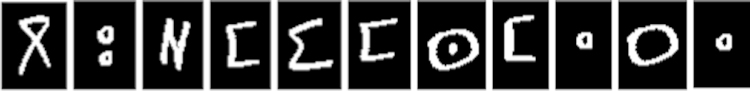
The segmentation in columns.